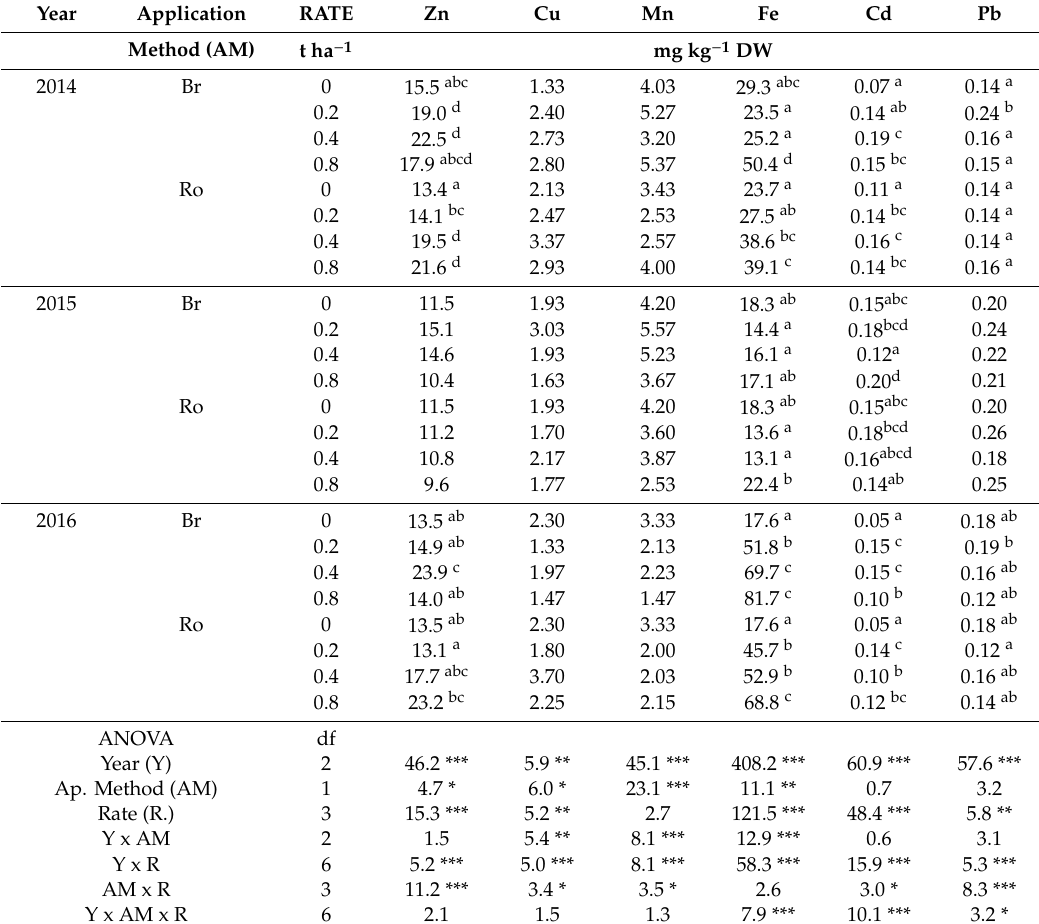
Table 7. Response of micronutrient and heavy metals concentration in maize grain to digestate application method and